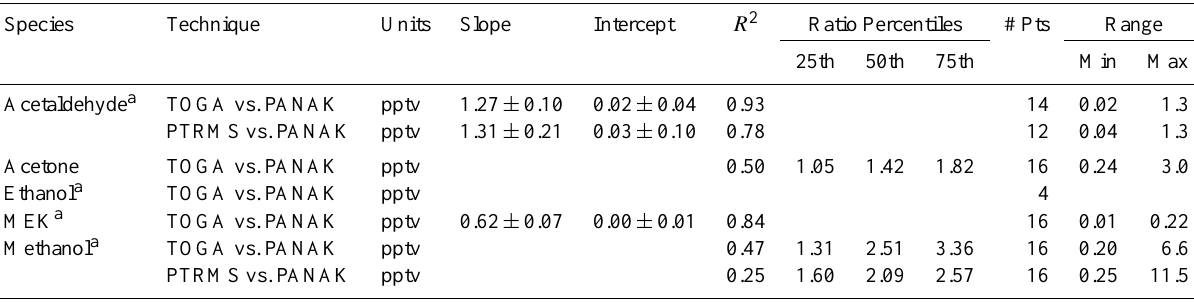
Table 3d. Statistical results of DC-8/C-130 intercomparison. Oxygenated volatile organic carbons. NOTE: Technique is listed as X (C-130) vs. Y